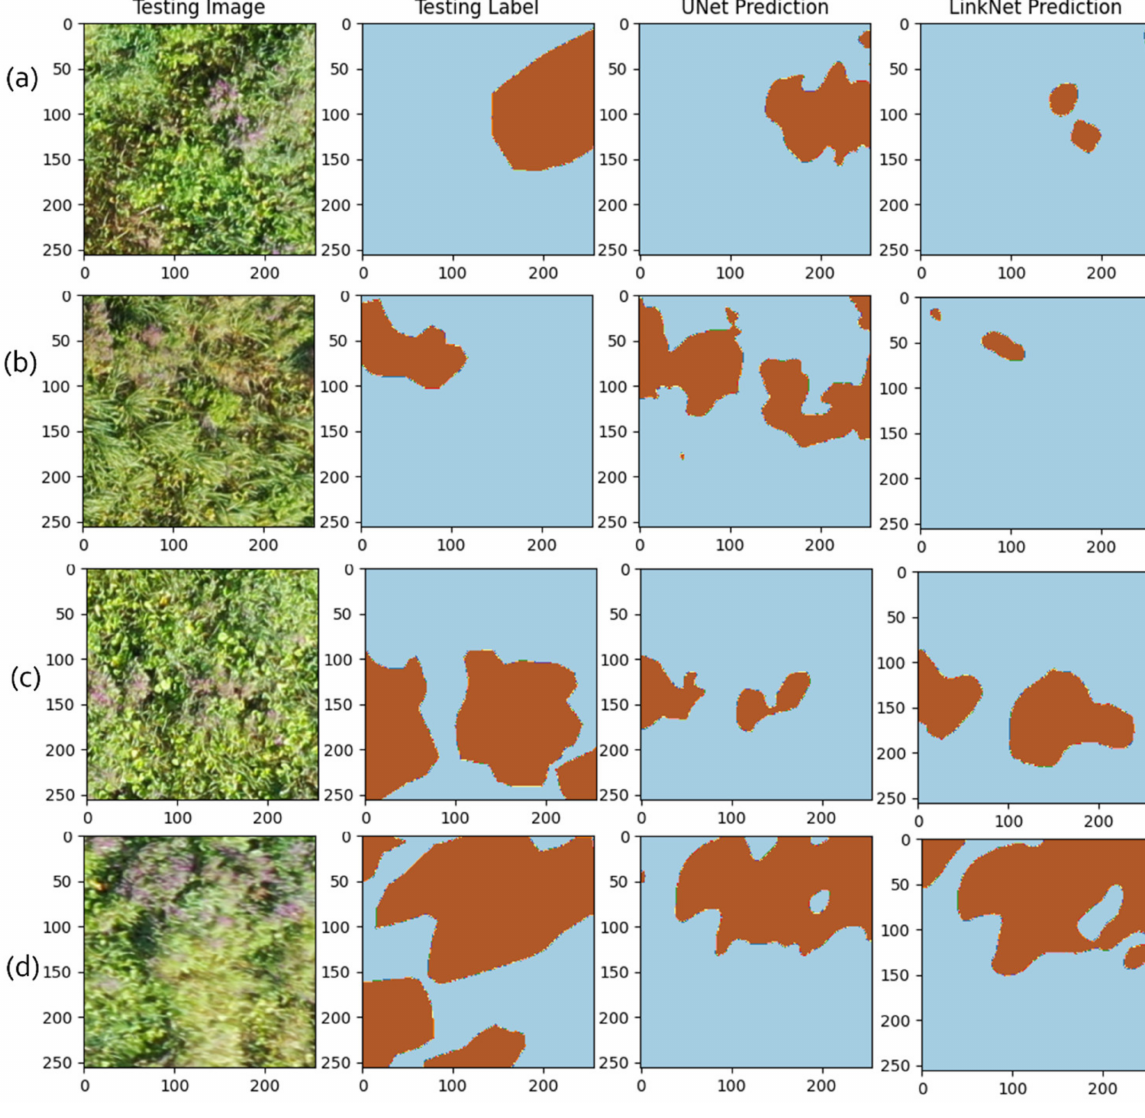
Figure 9. Selected images showing mismatches between ground-truth masks (testing labels) and U-Net and LinkNet prediction. Each subfigure demonstrates how the U-Net and the LinkNet models were able to detect the purple loosestrife patches even when the masked data represented a generalized and aggregated outline, and the image was distorted due to